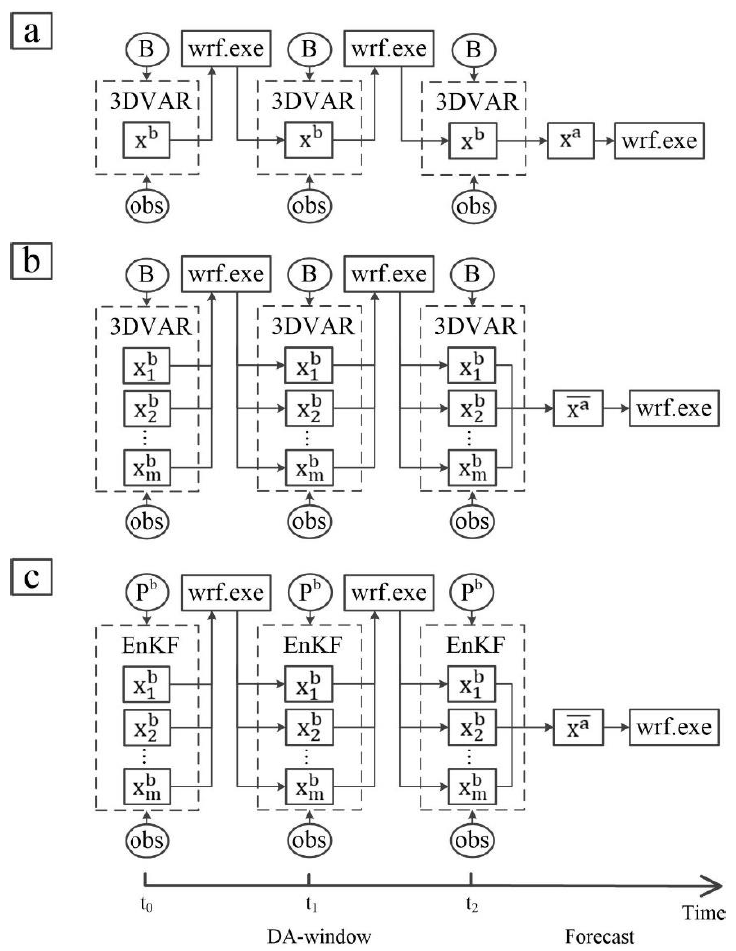
Figure 3. Flowcharts for data assimilation schemes: ( a ) DA-1, ( b ) DA-2, and ( c ) DA-3. See details in the text.